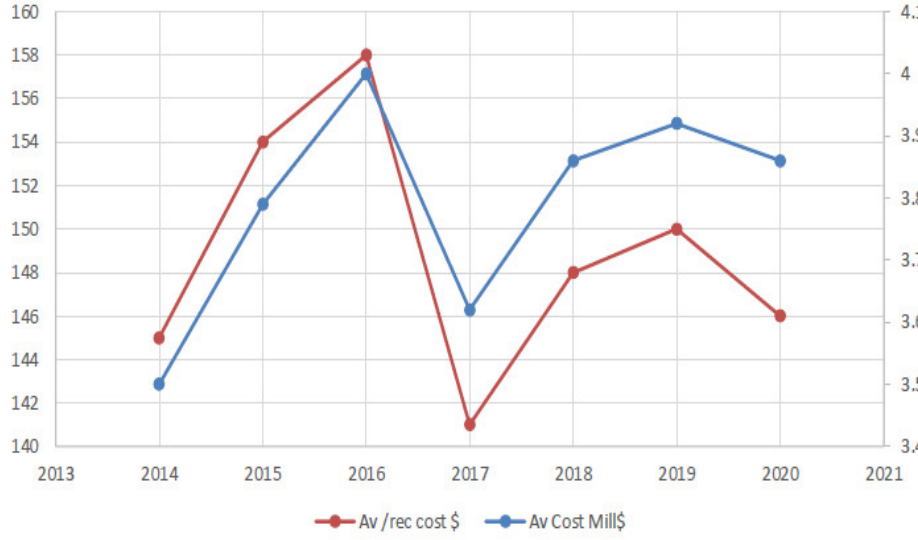
Figure 1. Average cost per record and average cost of a data breach [6].